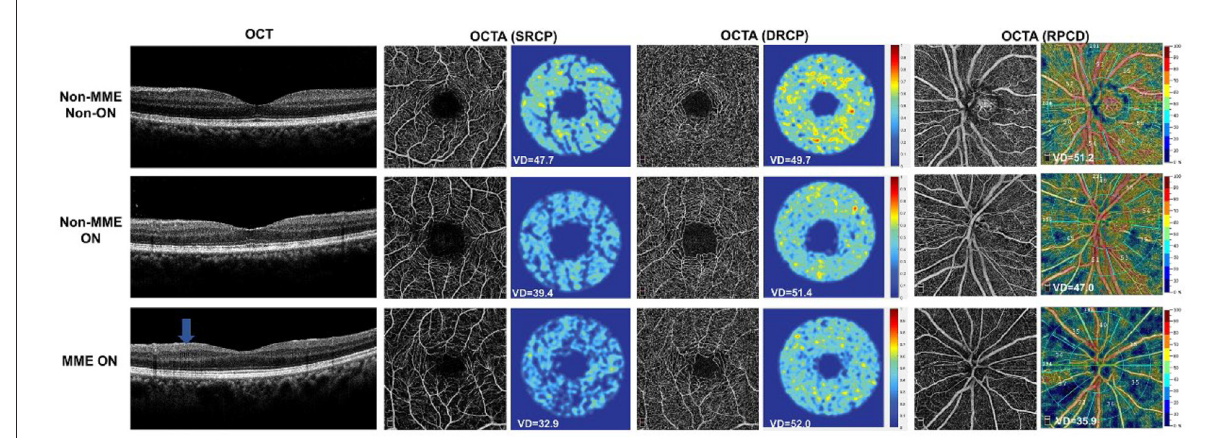
FIGURE3 Representative OCT and OCTA images and retinal capillary perfusion maps of non-MME non-ON, non-MME ON, and MME ON eyes. The OCT image in the third row shows that that microcystic macular edema located in the inner nuclear layer (blue arrow). OCT, optical coherence